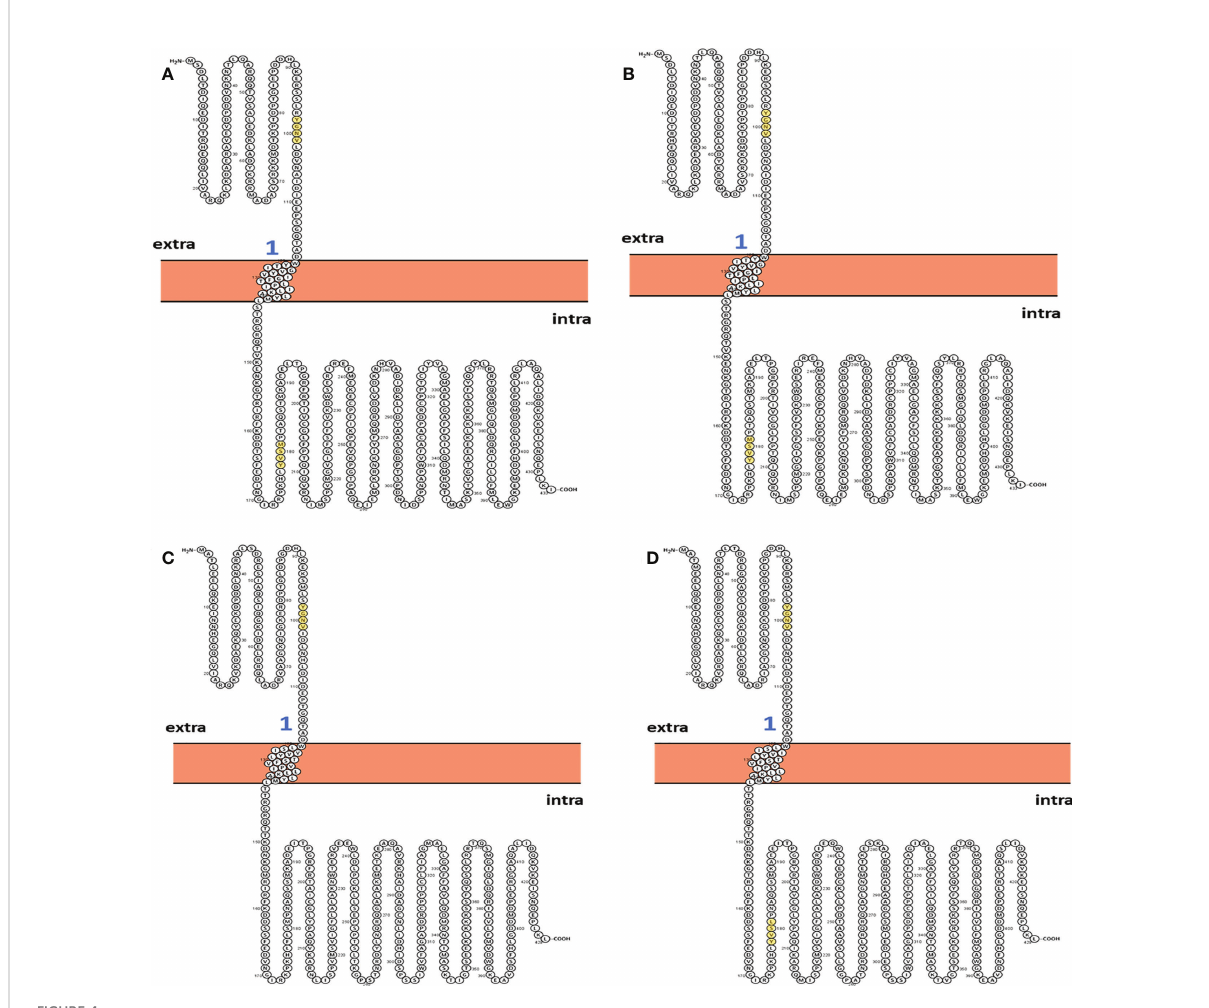
FIGURE 4 2D Topology of (A) PUUV, (B) SEOV, (C) DOBV, and (D) HTNV